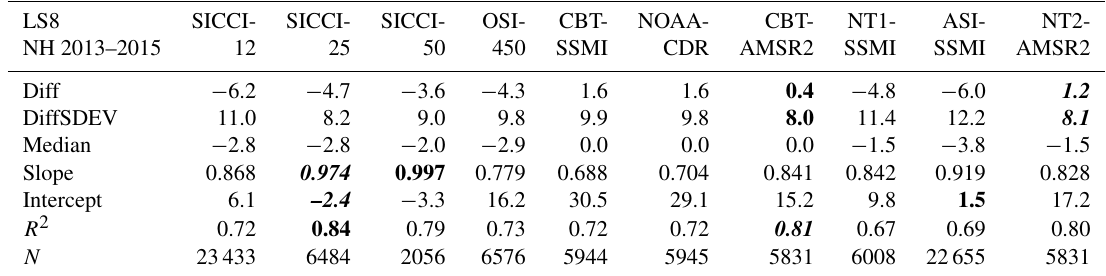
Table 6. Summary of statistical parameters shown in Fig. 3. See Table 5 for an explanation of the parameters